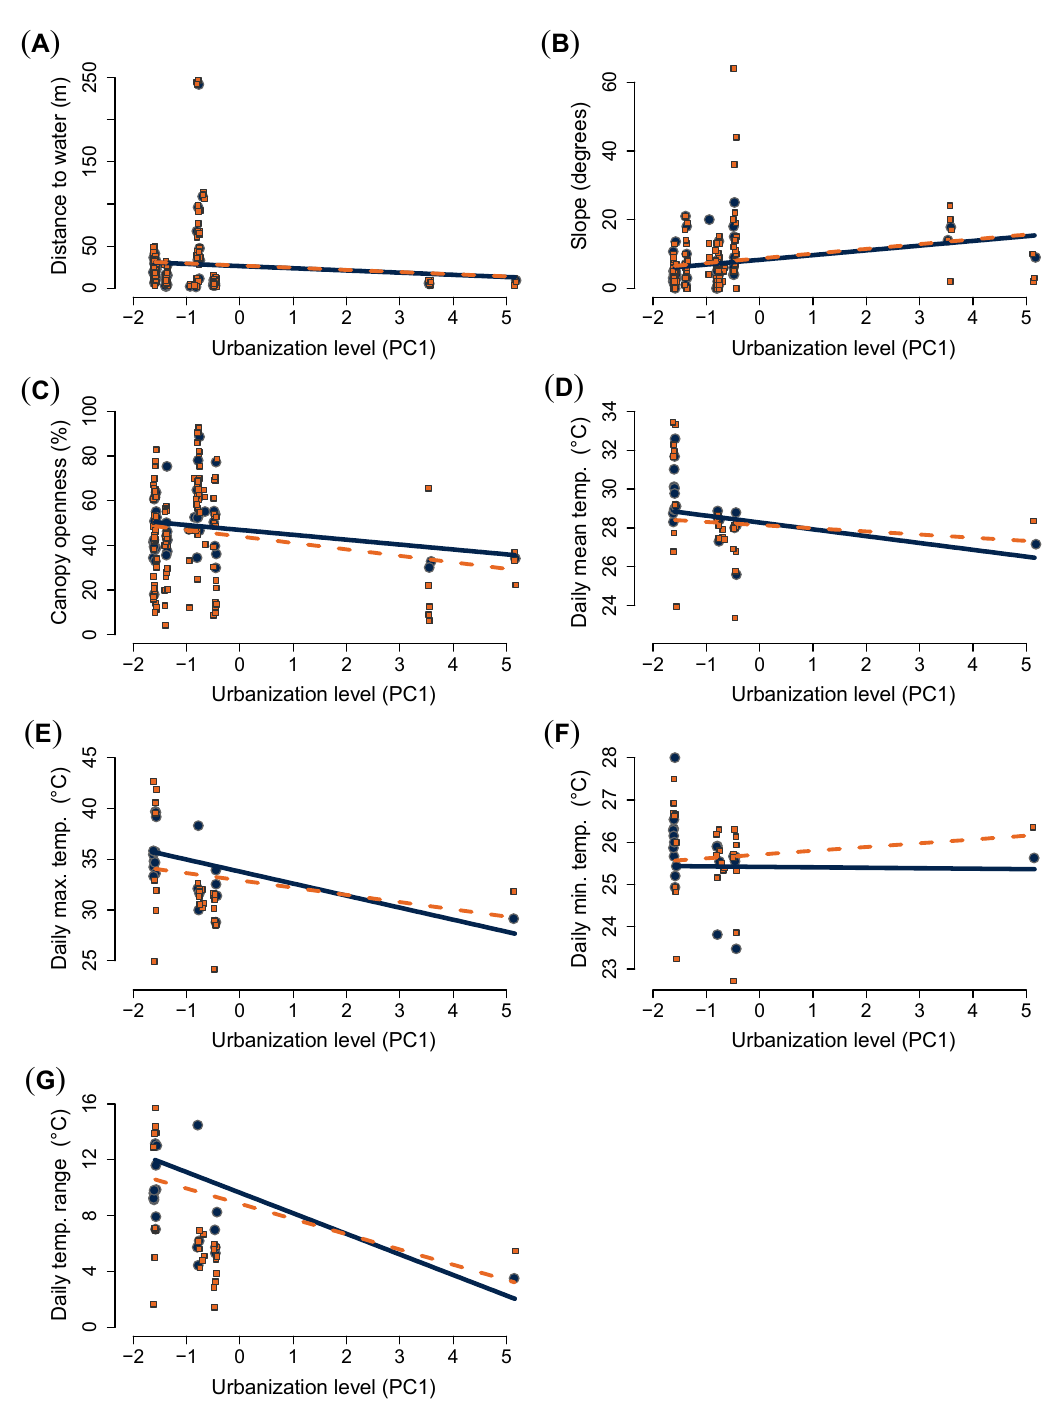
Figure 2. Effects of urbanization level for natural (blue circles, solid lines) and artificial (orange squares, dashed lines) nests on microhabitat variables. ( A ) Distance of nests from the edge of water of the nearest pond. ( B ) Ground slope around nest sites. ( C ) Canopy openness over nests. ( D ) Daily mean nest temperature. ( E ) Daily maximum nest temperature. ( F ) Daily minimum nest temperature. ( G ) Daily temperature range. Table 4. Effects of urbanization, nest type (natural vs. artificial), and their interaction on microhab- itat variables. iButton depth was only included in the analyses of temperature data. The effect size for nest type was calculated with the natural nest as the intercept/reference. The rightmost two col- umns indicate whether residual variance differed between natural (N) and artificial (A) nests, and if so, what the two separate variances are (natural nests listed first, artificial nests second). Estimates